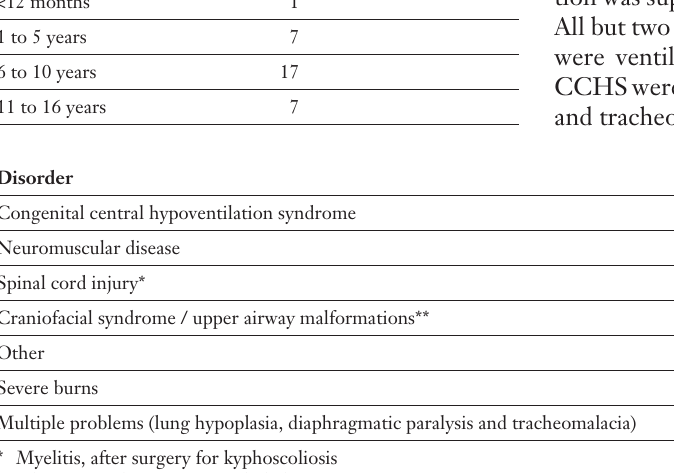
Number of children on home ventilation in Switzerland in 2000 according to age.